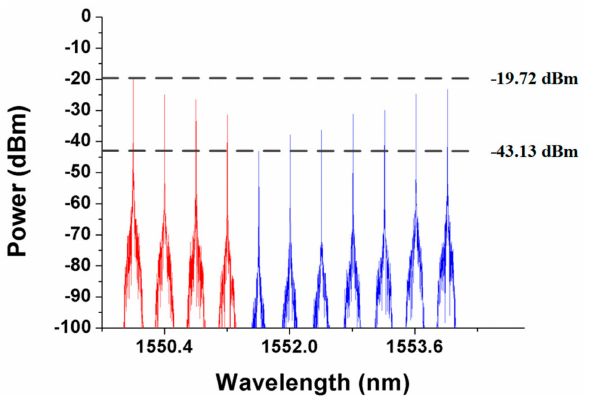
Figure 7. Detection signals received by the CO when the second phase of the first detection step is